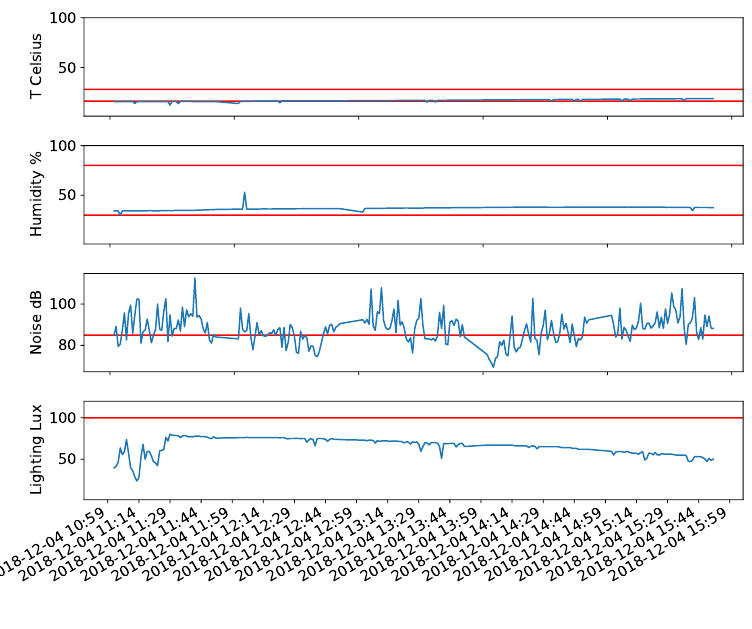
( a ) Physical environmental conditions.